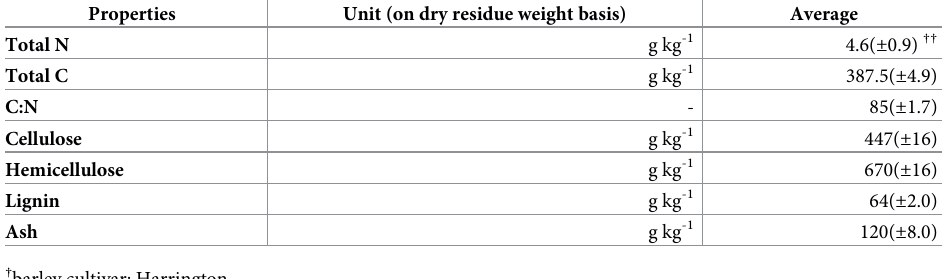
Table 2. Basic properties of barley † residue samples used in laboratory incubation study conducted at the Aber- deen Research and Extension Center, Aberdeen, ID, USA.